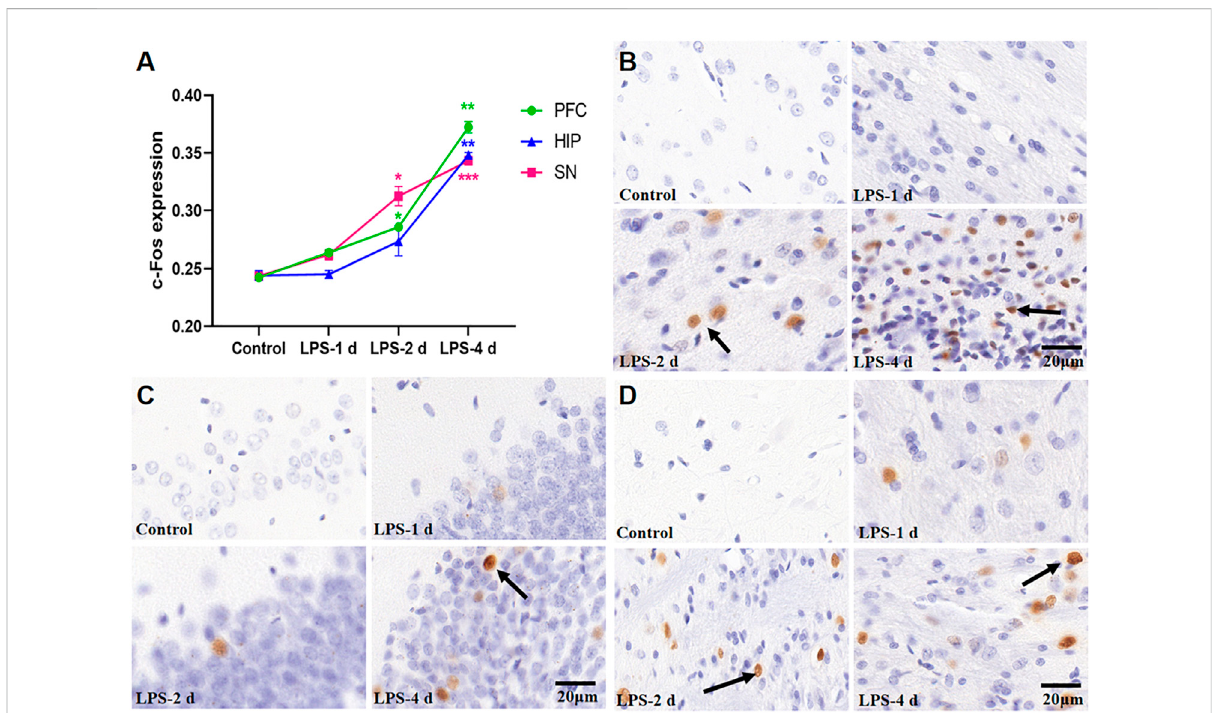
FIGURE 8 c-Fos expression in the PFC, HIP, and SN for all groups ( n = 3). (A) The average optical density (AOD) value of each group was compared. Data areexpressedasthemean±SEM.* p < 0.05,** p < 0.01,*** p < 0.005,comparedtothecontrolgroup. (B) Representativephotomicrographsofc-Fos expression in the PFC (×400). (C) Representative photomicrographs of c-Fos expression in the HIP (×400). (D) Representative photomicrographs of c-Fos expression in the SN (×400). The arrows showed the expression of